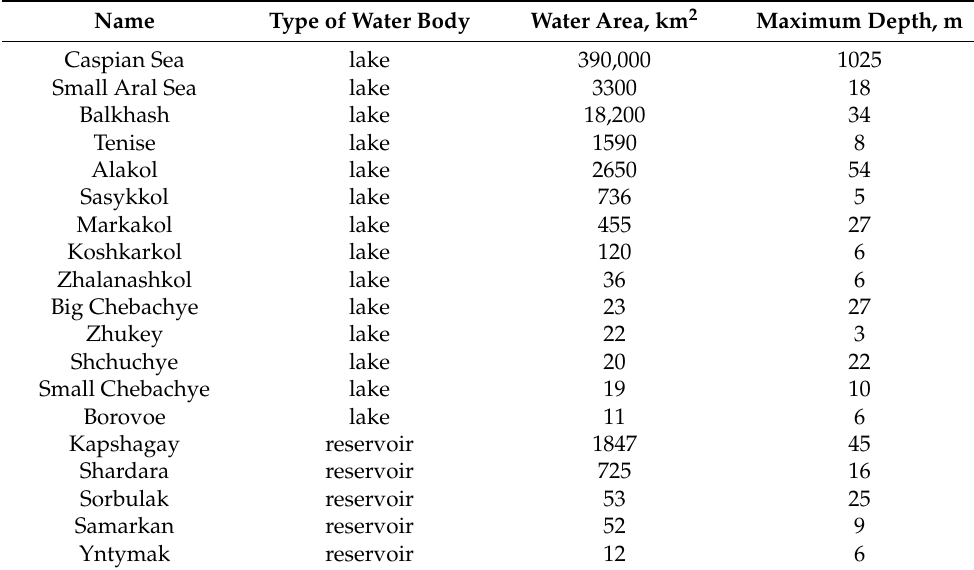
Table 1. Information about some surveyed water bodies in Kazakhstan.